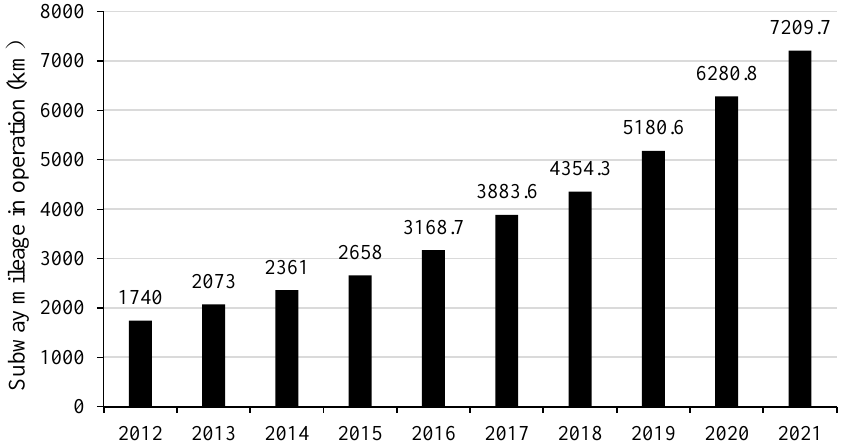
Figure 1. Length of subway lines in China from 2012 to 2021 (Data source: China Urban Rail Transit Association).